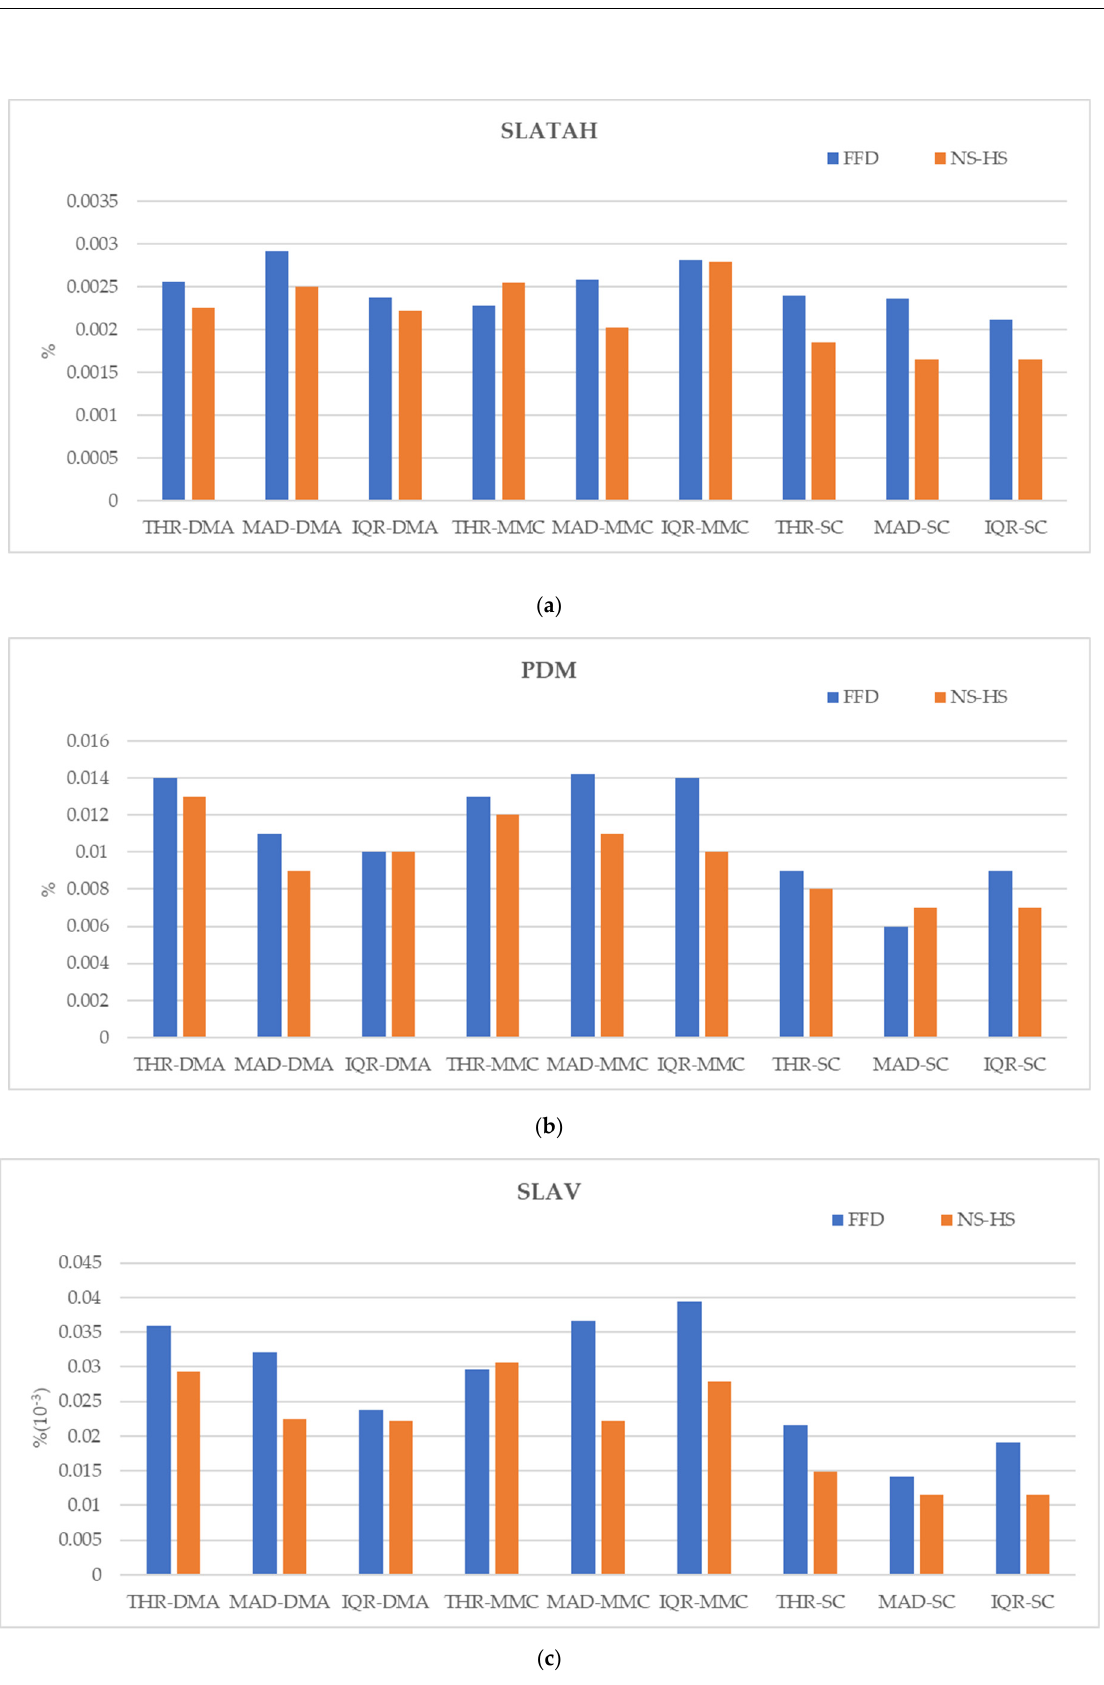
Figure 10. ( a ). Comparative experimental results of the performance measures to the SLATAH. ( b ). Comparative experi- mental results of the performance measures to the PDM. ( c ). Comparative experimental results of the performance measures to the SLAV.